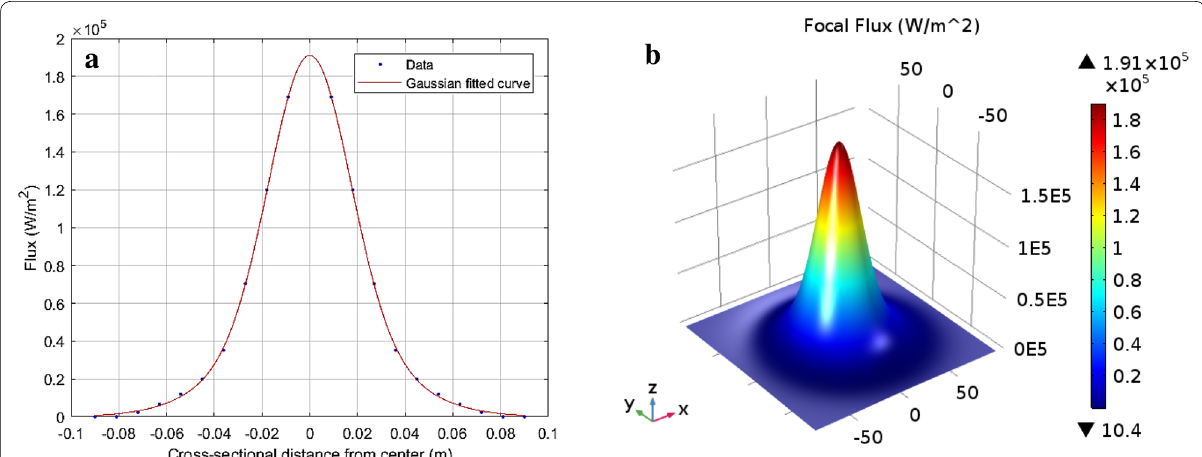
Fig. 9 Focal heat flux distribution in W/m 2 for the Stirling engine application. a Symmetrical real-data points and 2D second-order Gaussian regression from Qandil and Zhao (2018), b 3D second-order Gaussian plotted against receiver dimensions (mm) with COMSOL ®